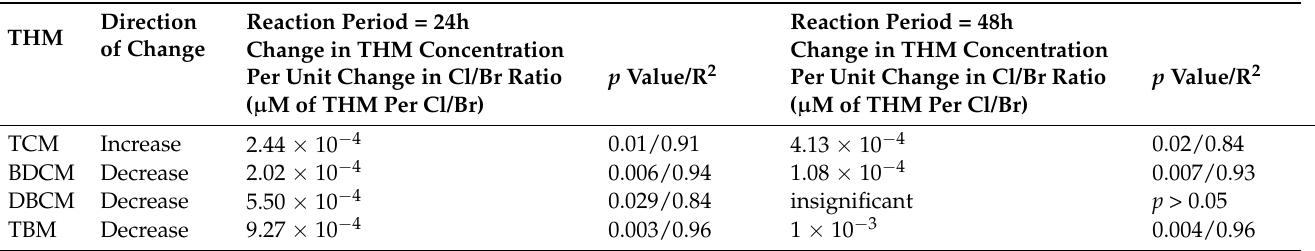
Table 3. Change in speciation and concentration of each THM with changing Cl/Br